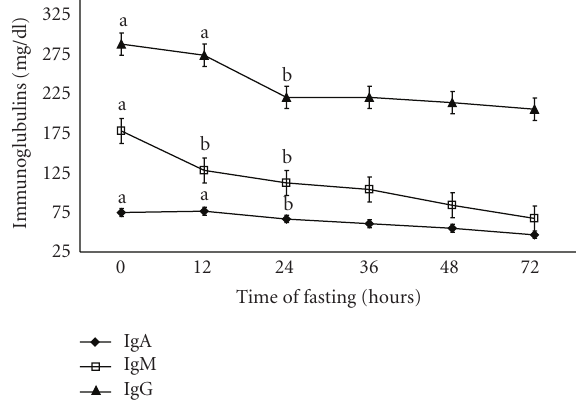
Figure 1: Concentration of immunoglobulins (IgA, IgM, and IgG) mg/dl in experimentally pregnant toxemic goats. Di ff erences in the letters indicate beginning of the significant di ff erences.